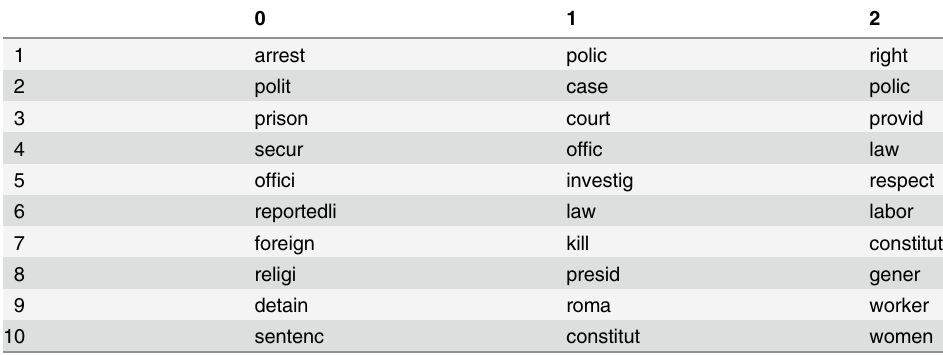
Table 10. Ten most important words for the CIRI Freedom of Speech and Press variable. 0